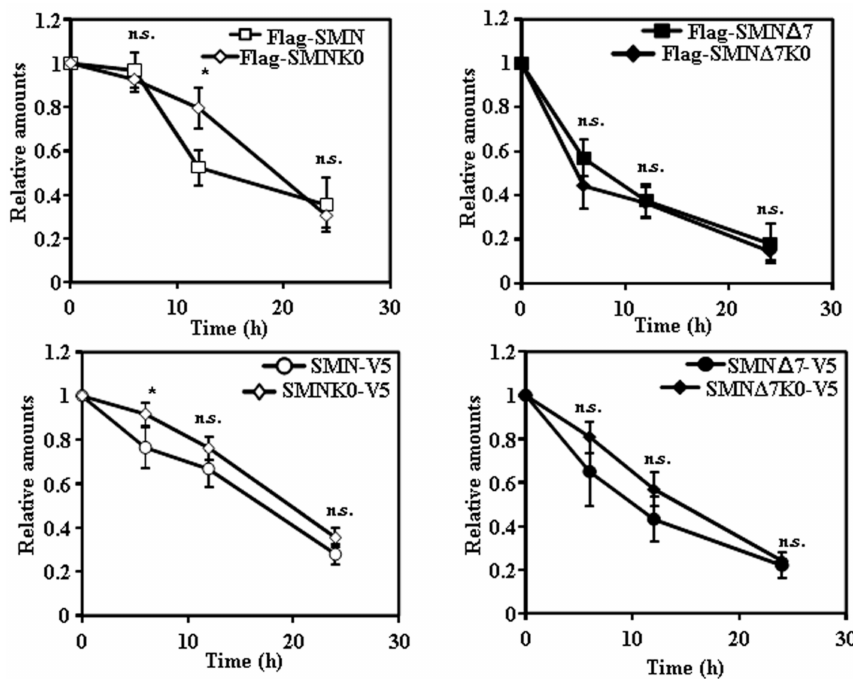
Figure 6. Comparisons of the time-course of degradation of SMN and SMN ∆ 7 tagged at the N- or C-terminus with the corresponding Lys-less (K0) mutants. The data for these plots are derived from previous results shown in Figures 2–5. Asterisks indicate a statistical significant difference between pairs (* p < 0.05, Student’s t -test). n.s., not